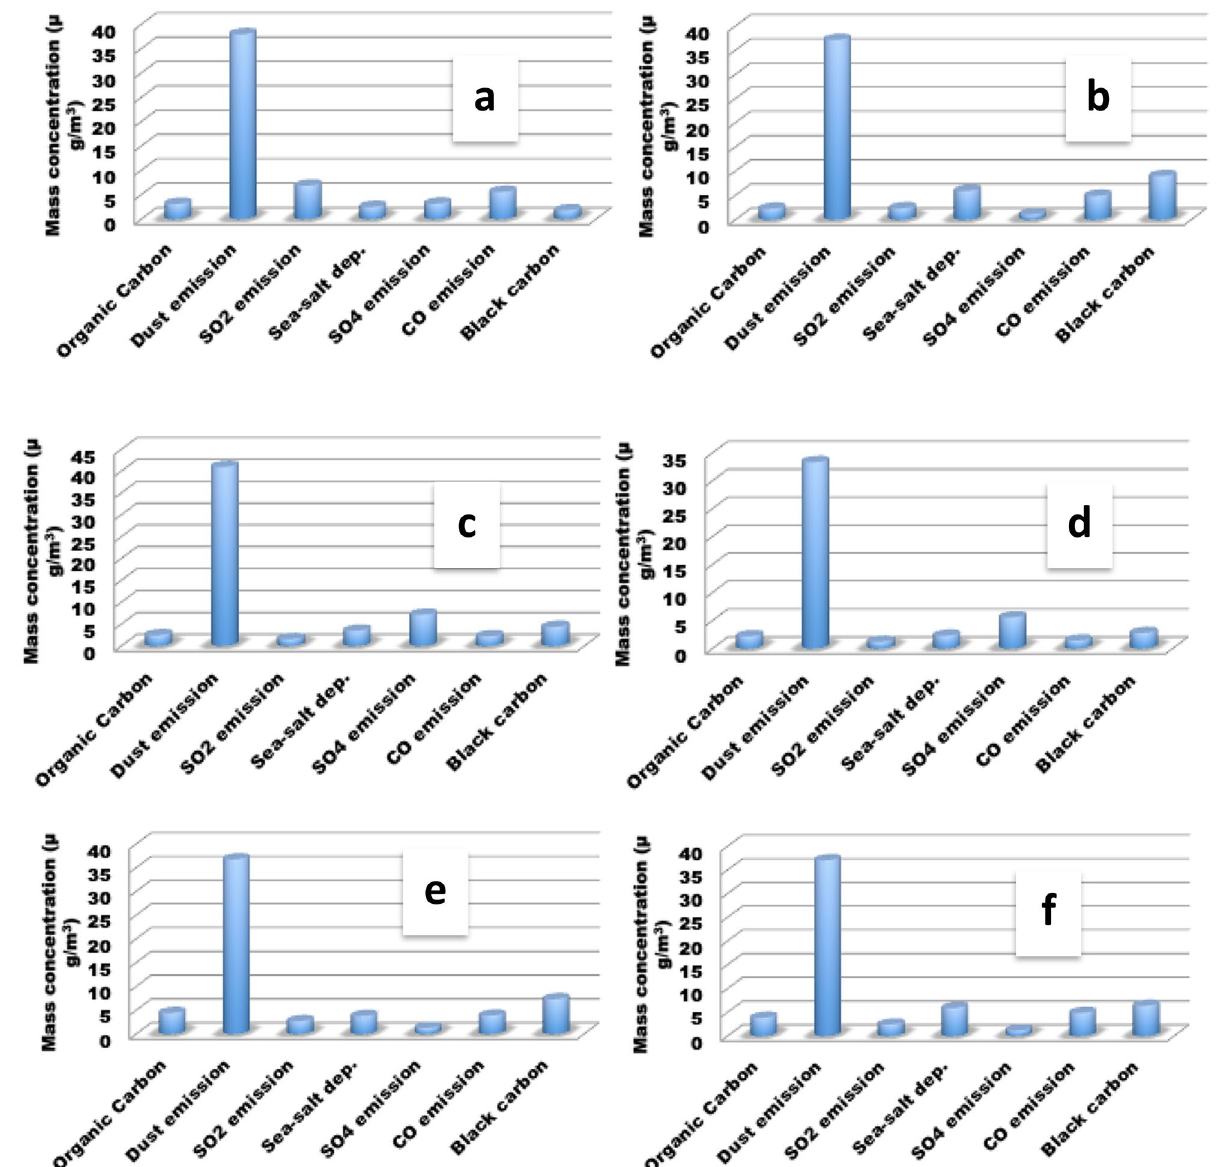
Figure 4. Satellite measurement of major pollutants ( a ) Kano, north-west GZ ( b ) Aba, south-east GZ ( c ) Abuja, north-central GZ ( d ) Borno, north-east GZ ( e ) Lagos, south-west GZ ( f ) Port Harcourt, south-south